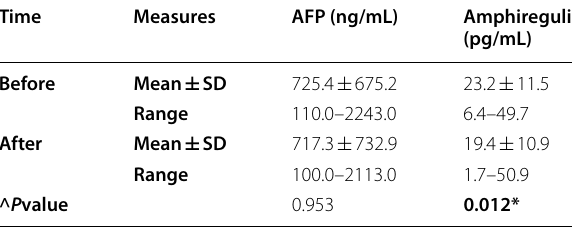
Table 5 Comparison between serum amphiregulin and